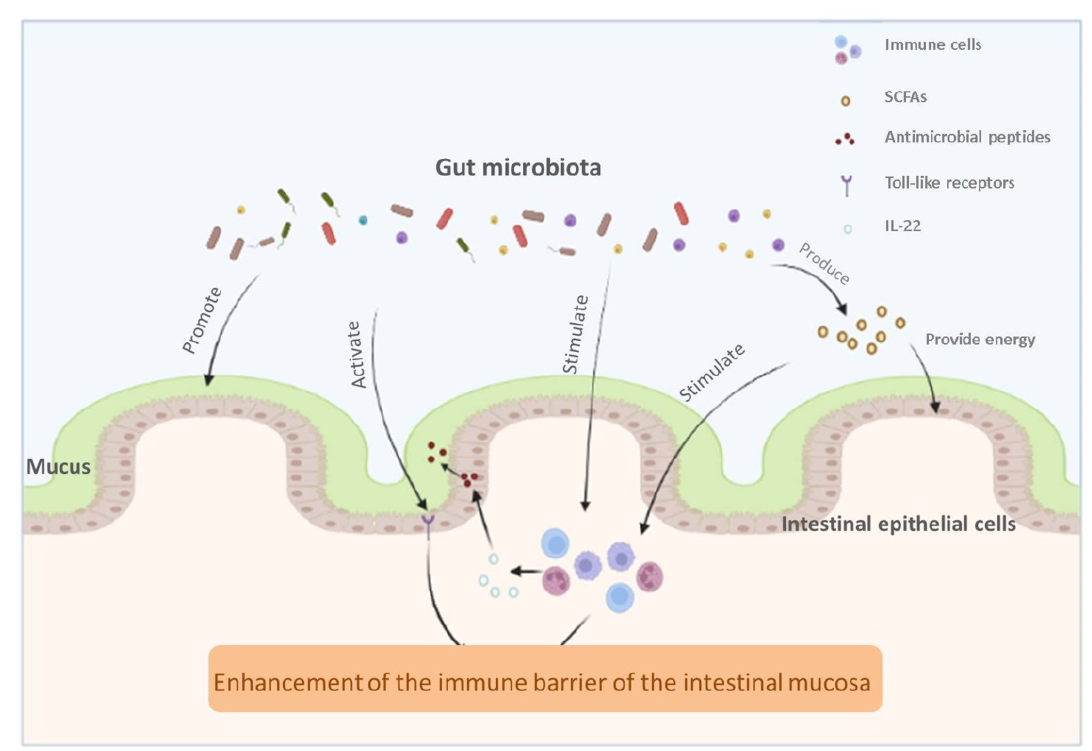
Figure 2. The relationship between intestinal microbiota and intestinal mucosa.